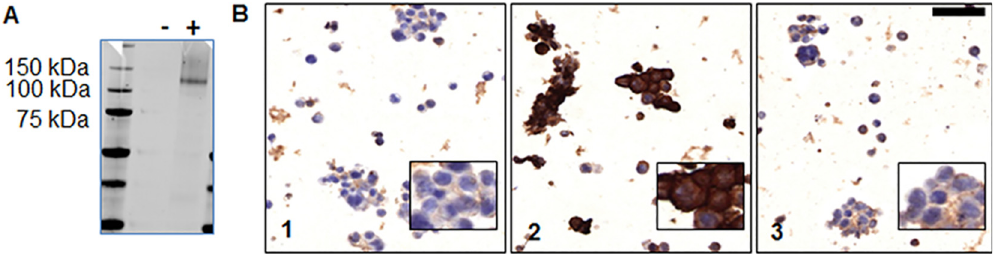
Fig 3. Accuracy of NRP-1 receptor antibody. (A) Western blot analysis of NRP-1 transfected (+) HEK293 cells and wild-type (-) HEK293 cells. (B) NRP-1 immunohistochemistry performed on wild type (B1), NRP-1- (B2) and NRP-2- (B3) transfected HEK293 cells. Scale bar: 50 μ m.